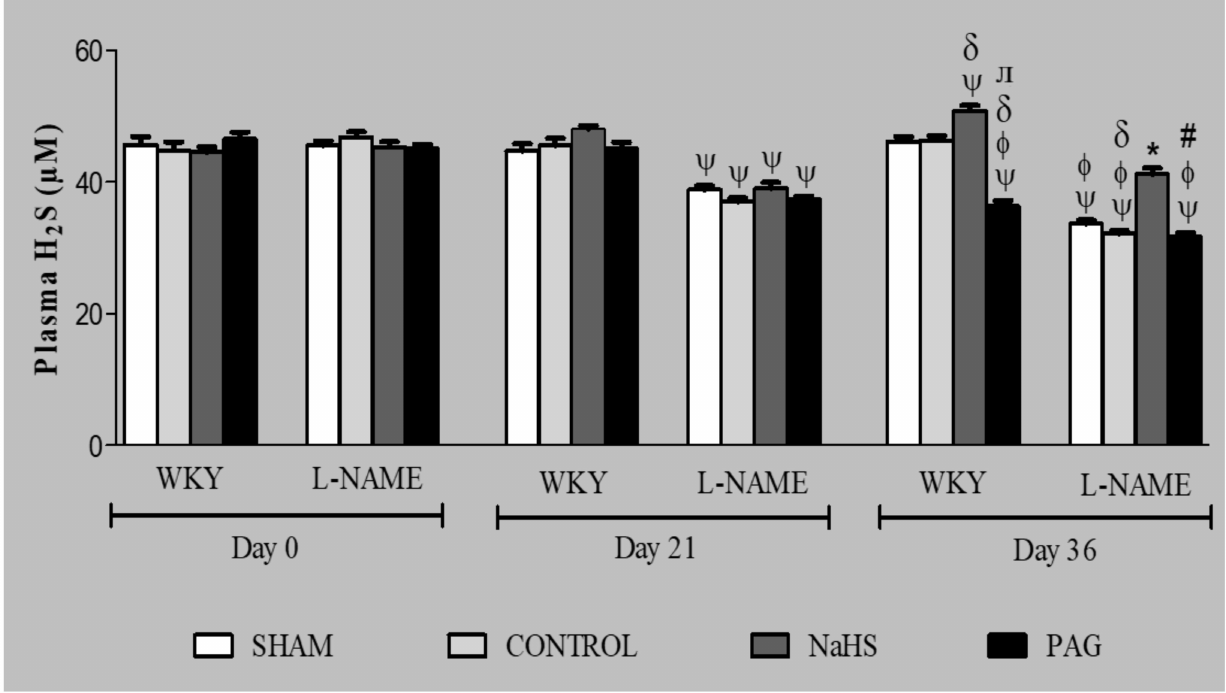
Figure 1. Plasma H 2 S concentrations on days 0, 21 and 36 ( n = 6) in different experimental groups of WKY and L-NAME rats. Data were analysed using repeated measures ANOVA followed by Bonferroni’s post hoc test. Ψ p < 0.05 vs. day 0 of respective groups; φ p < 0.05 vs. day 21 of respective groups; δ p < 0.05 vs. WKY-CONTROL on day 36; л p < 0.05 vs. WKY+NaHS on day 36; * p < 0.05 vs. L-NAME-CONTROL on day 36; # p < 0.05 vs. L-NAME+NaHS on day 36. H 2 S = hydrogen sulphide, WKY = Wistar Kyoto rats, L-NAME = L-nitro-methyl-arginine-ester, PAG =